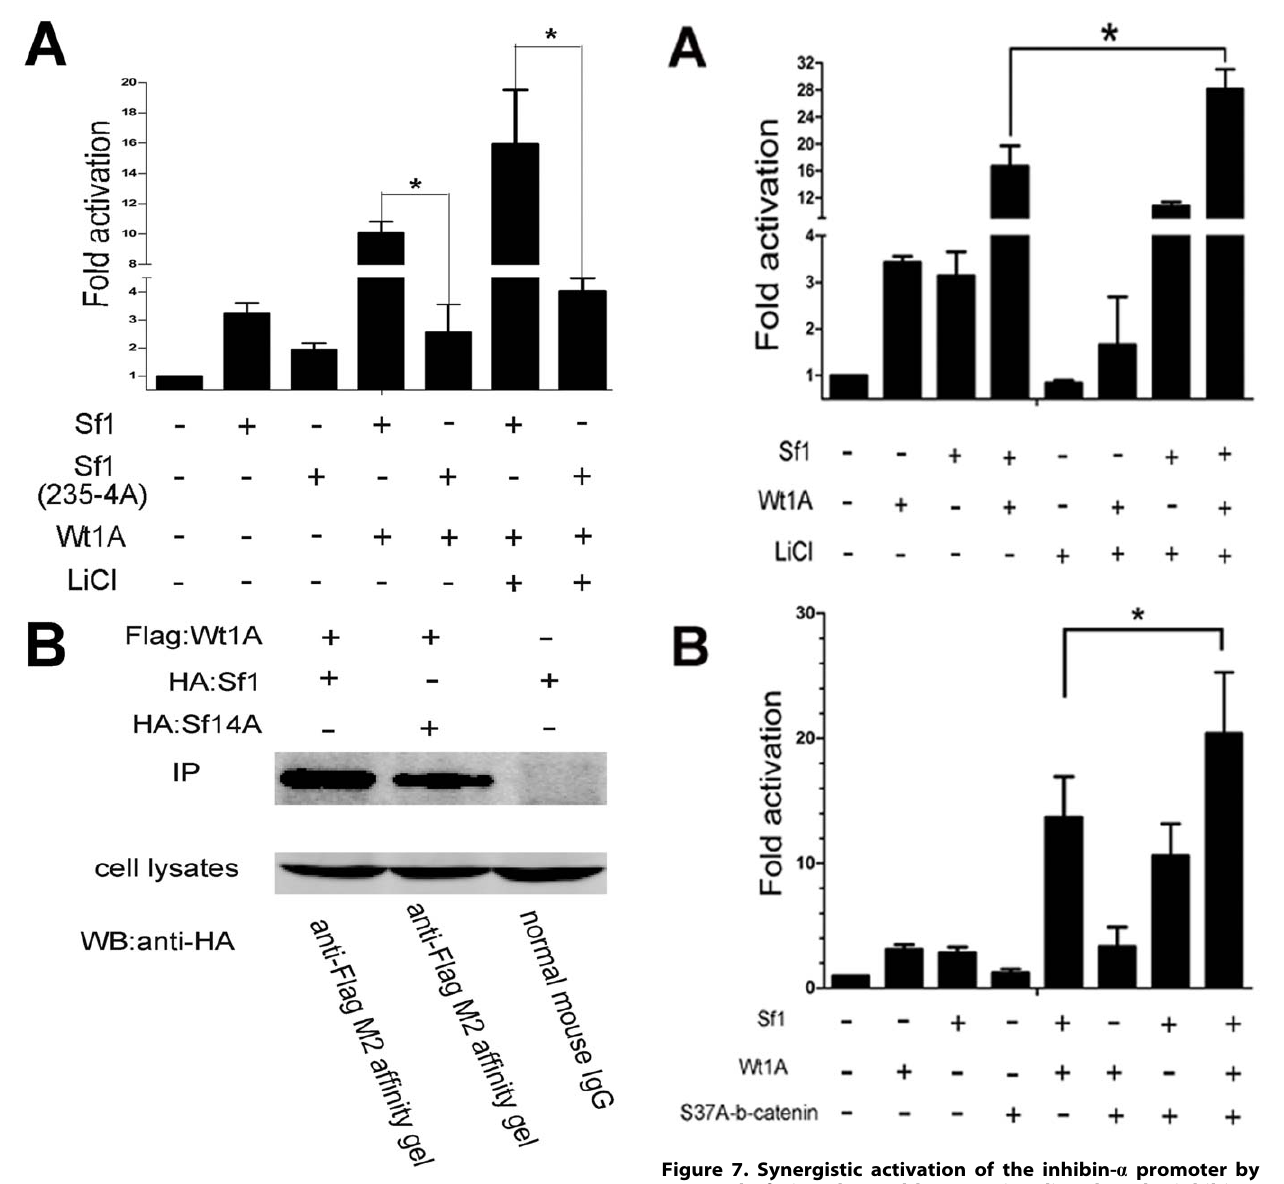
Figure 6. The Sf1 ligand-binding domain (residues 235–238) is essential for Wt1 and Sf1 synergistic activation of the inhibin- a promoter, but does not affect the interaction between Wt1 and Sf1. A. Mutations of the Sf1 ligand-binding domain (residues 235–238) completely abolish the synergistic action of Wt1 and Sf1 on the inhibin- a promoter. B. Interactions between Wt1 and Sf1 proteins were assessed by co-immunoprecipitation; both wild type Sf1 and Sf1 (235– 238 4A) interacted with Wt1 protein. Normal mouse IgG served as a negative control.